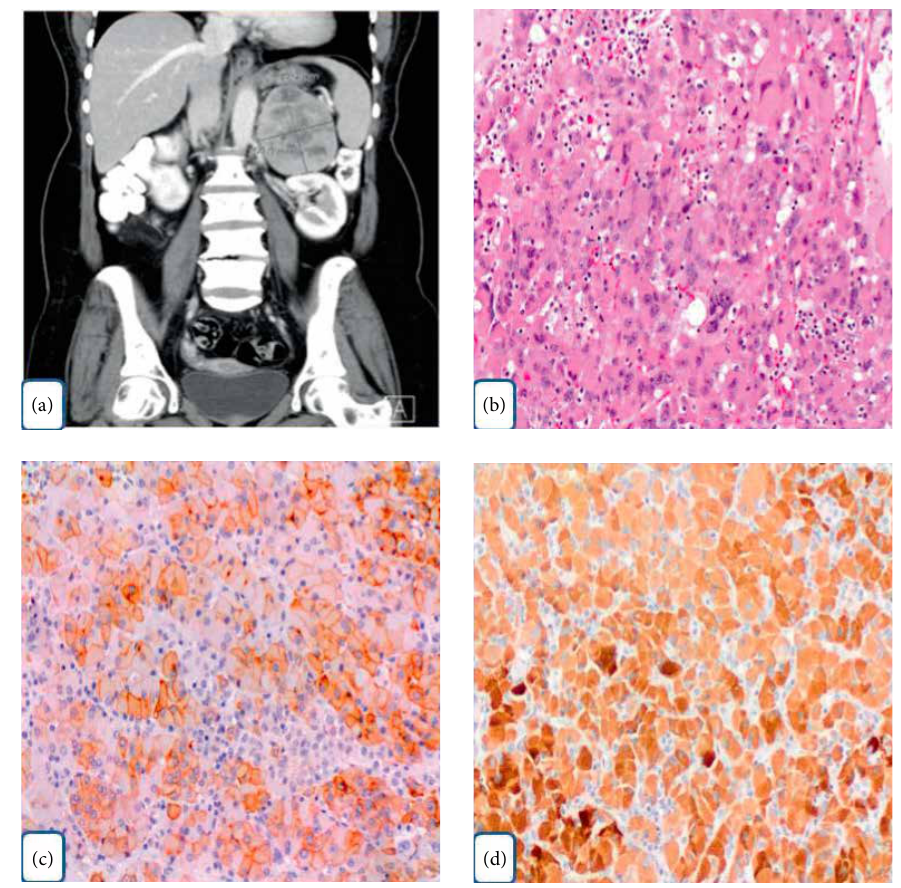
Figure 1: (a) CT scan of abdomen illustrates the left supra-renal mass. (b) Oncocytic adrenocortical neoplasm (H&E 100x). (c) Tumor cells expressing positive staining for synaptophysin (100x). (d) Tumor cells expressing positive staining for Melan-A